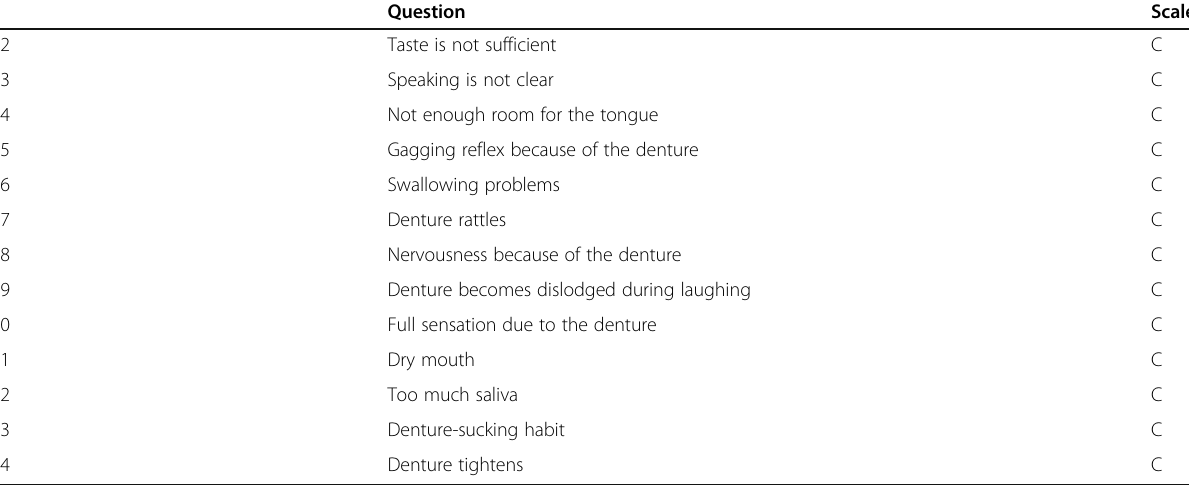
Table 5 Questions of patient satisfaction questionnaire divided into six scales (A, functional problems of the lower denture; B, functional problems of the upper denture; C, functional problems complaints in general; D, facial esthetics; E, accidental lip, cheek, and tongue biting “ neutral space ” ; F, esthetics of the denture)